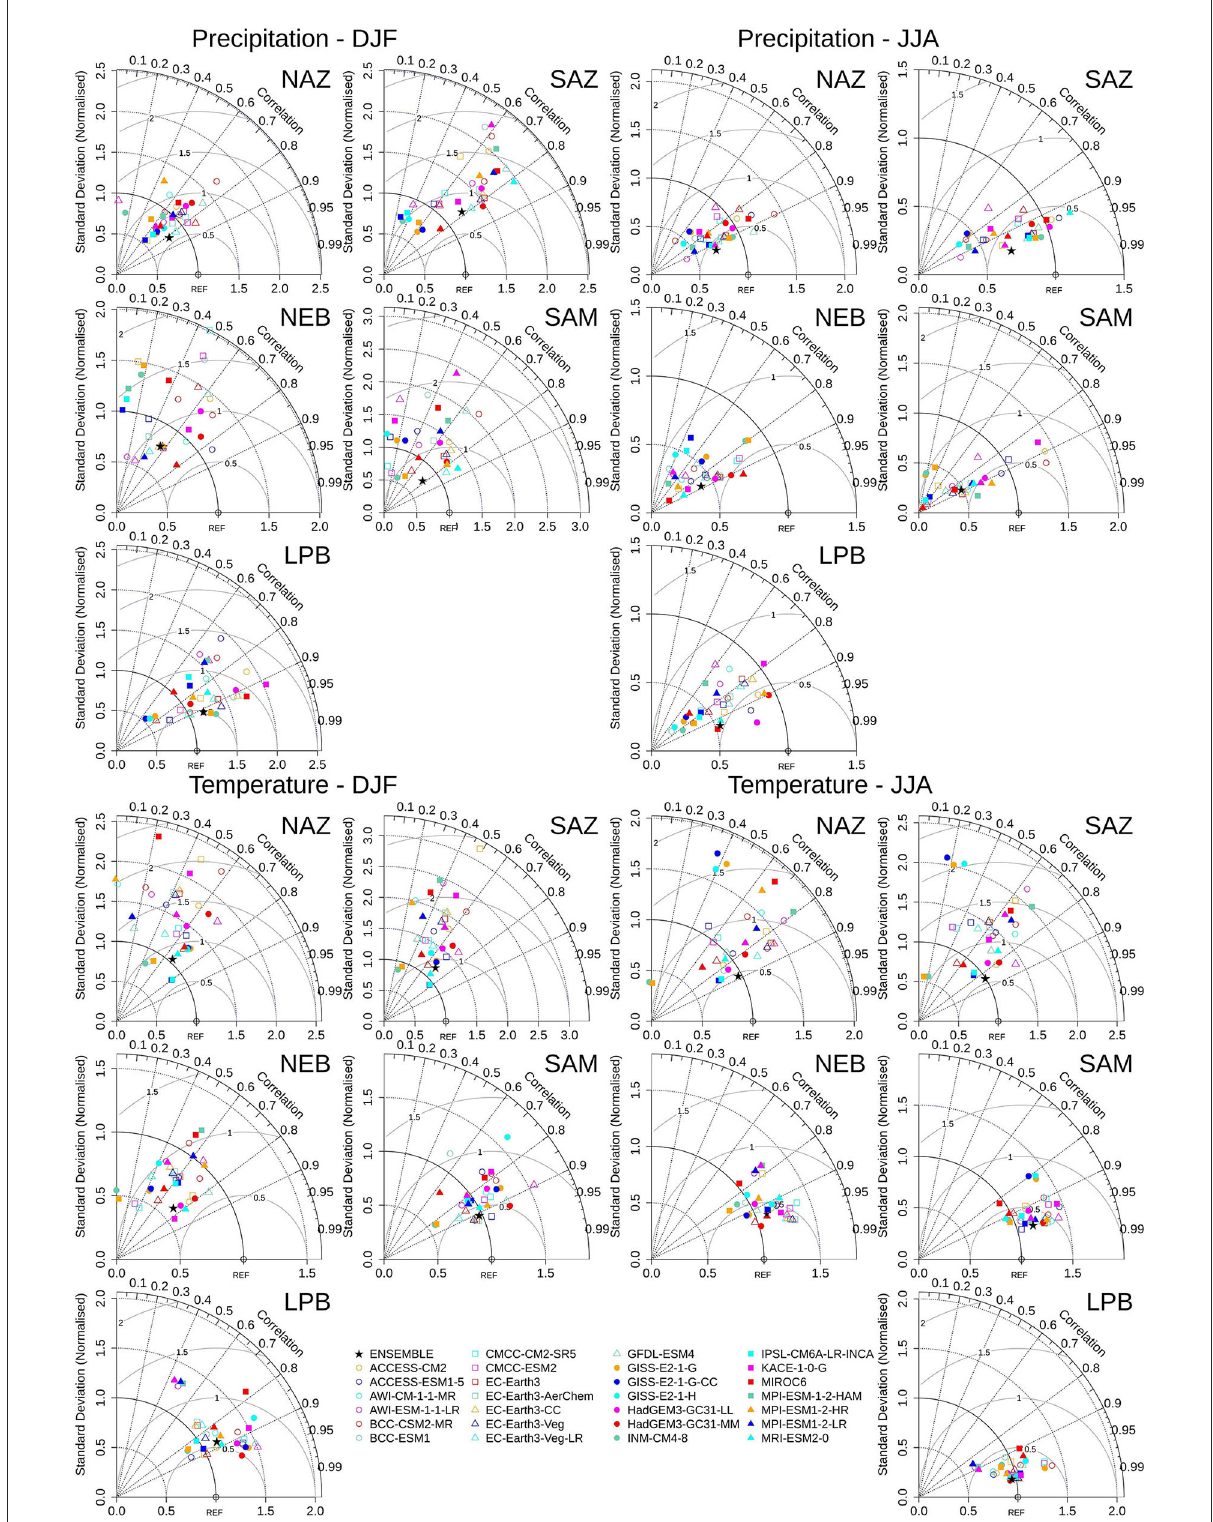
FIGURE14 The Taylor diagram for CMIP6 models precipitation (top) and temperature (bottom) simulation in summer (DJF) (left) and winter (JJA) (right) over each sub-region. The angular coordinate at the right side of each diagram corresponds to the R; the radial distance from the origin represents the ratio of the standard deviation of the simulation to that of the observation, and the distance from the reference point (observations) is a measure of the